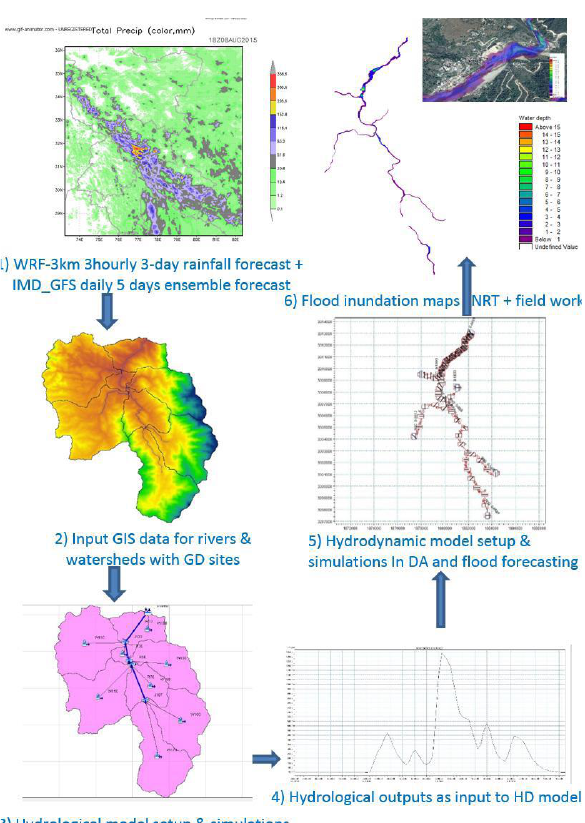
Figure 2. Overall methodology pictorial